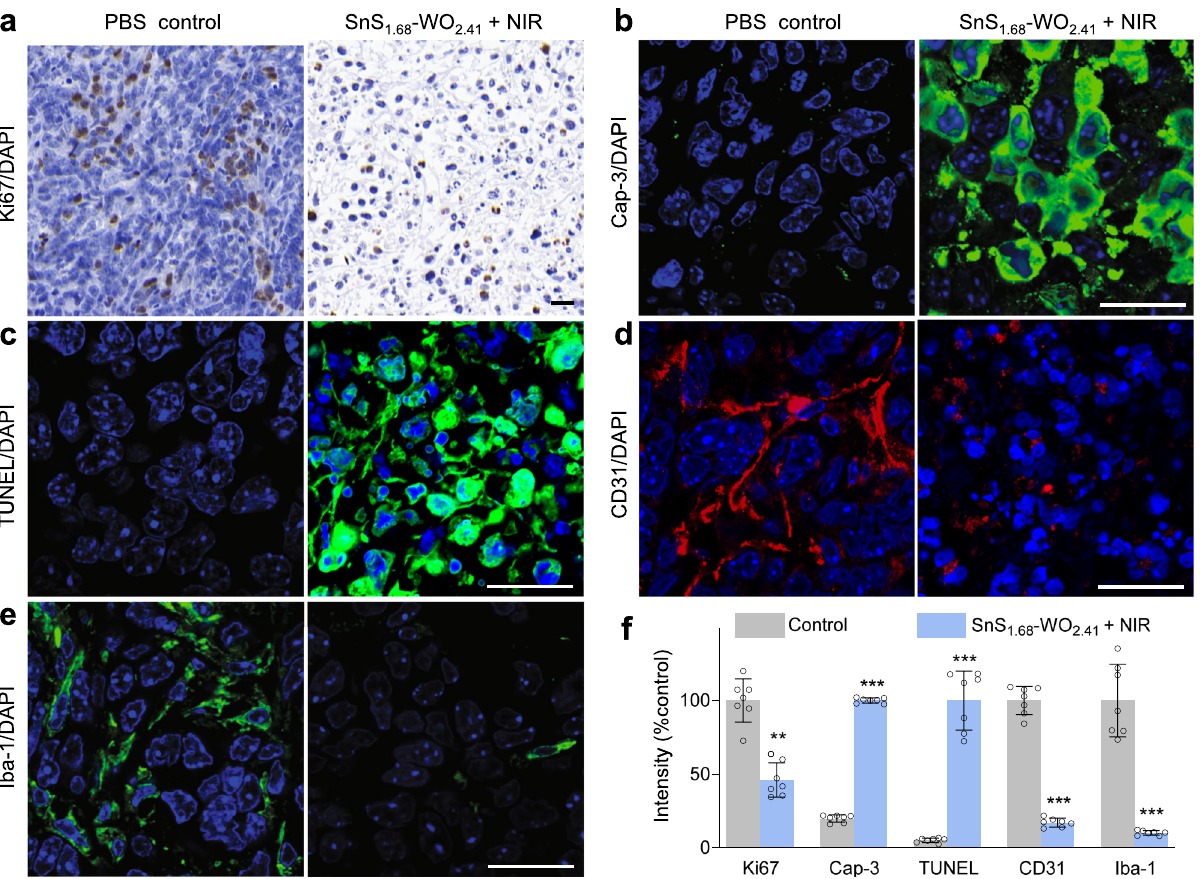
Fig. 6 The change of TME after hole/hydrogen therapy with the SnS 1.68 – WO 2.41 nanocatalyst. Immunohistochemical analysis of Ki67 + proliferating cells ( a ), caspase-3 + apoptotic cells ( b ), TUNEL + apoptotic cells ( c ), CD31 + tumor vessels ( d ), and Iba1 + tumor-associated macrophages ( e ) in 4T1 tumors, and corresponding quanti fi cation results ( n = 7 biologically independent samples) ( f ). All the scale bars, 20 μ m. P values were calculated by the two-tailed Student ’ s t -test (** P = 0.000006, *** P < 0.000001). Data are presented as mean values ± (Supplementary Fig. 16). By virtue of hole/hydrogen therapy, both GSH depletion and hydrogen regulation upon tumor tissue could spread over the whole of TME, destroy the ADS in TME, and in fl uence all tumor and tumor-associated stromal cells because of high tissue penetration of GSH and hydrogen molecules. Such a special feature of hole/hydrogen therapy is distinctly different from that of general drug therapies because of no drug resistance and no limitation of tissue penetration of nanoparticles, implying underlying clinical values of drug-free therapy.